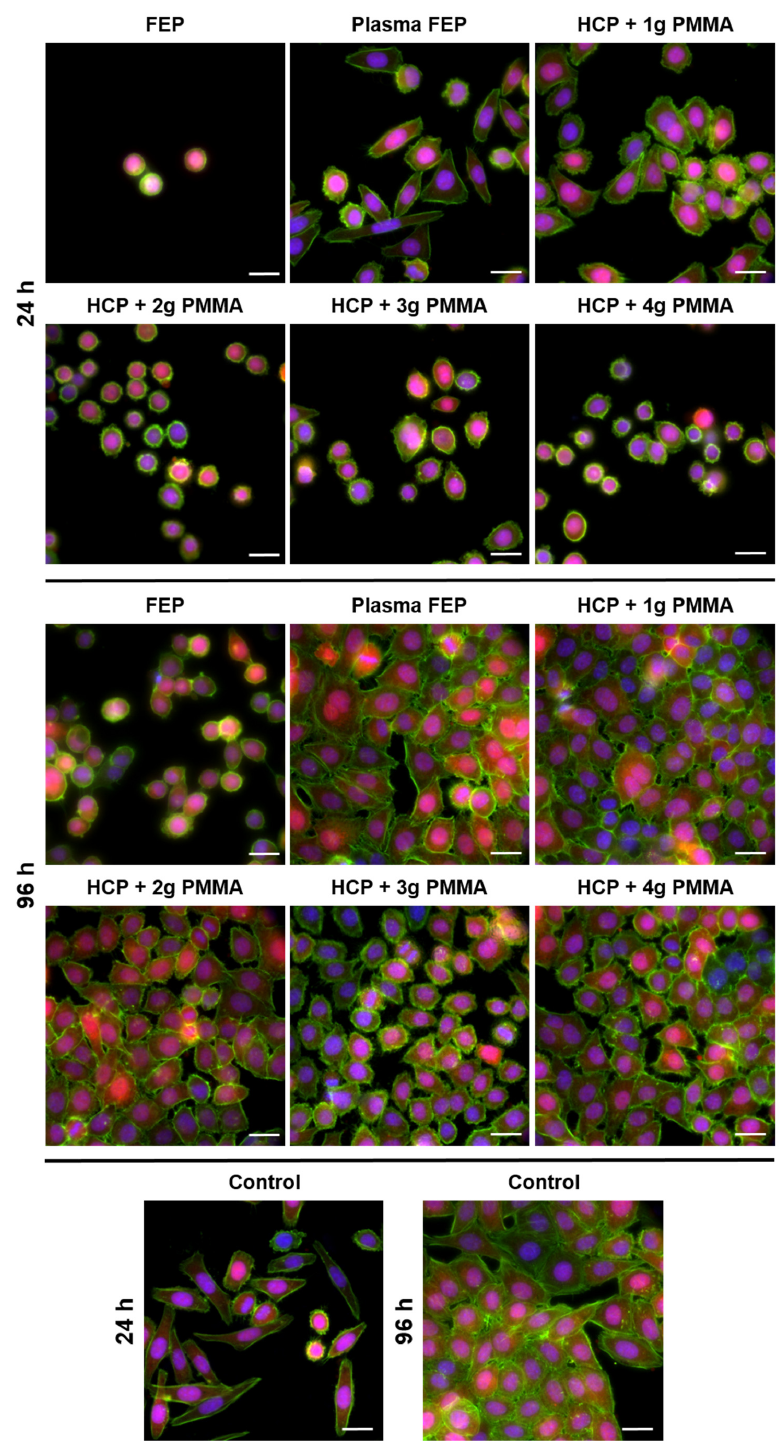
Figure 6. Fluorescence microscopy images of VAMPIRO U-2 OS cells (human cells derived from osteosarcoma, stably transfected with tFP602) growing on fluorinated ethylene propylene (FEP) treated by 8W plasma for 240 s and subsequently coated with a honeycomb-like pattern formed from polymethyl methacrylate (PMMA) solution containing its different amount (1, 2, 3, and 4 g). Left and right columns-cells 24 and 96 h post-seeding, respectively. As controls, tissue culture polystyrene (TCPS), pristine FEP, and plasma-treated (8 W, 240 s) FEP matrices were used. In green—-cell cytoskeleton, in blue—-cell nuclei, in red—-cell cytoplasm. Scale bar represents 20 µ